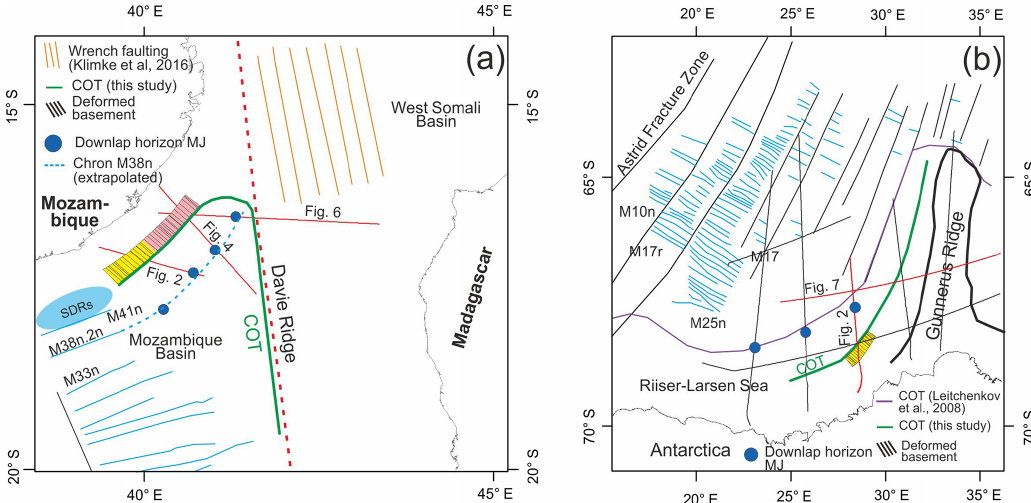
Figure 9. Sketch map illustrating the location of the deformed basement observed at the foot of the continental slope in the Mozambique Basin (a) and the Riiser-Larsen Sea (b) . Solid lines indicate the location of Profiles A to E (Figs. 2, 4, 6 and 7). Blue and black lines highlight magnetic anomalies and fracture zones in the Mozambique Basin and Riiser-Larsen Sea according to Leinweber and Jokat (2012), Leitchenkov et al. (2008) and Müller and Jokat (2017). The continent–ocean transition (COT) as proposed in this study is shown in green. The continent–ocean transition according to Leitchenkov et al. (2008) in the Riiser-Larsen Sea is shown in purple. Orange lines indicate wrench faulting in the West Somali Basin (Klimke et al., 2016). Blue dots mark onlap locations of horizon MJ against oceanic basement. The dashed blue line marks the extrapolation of magnetic chron M38n (Müller and Jokat, 2017) to the study area in the Mozambique Basin. The extrapolation was done by noting the distance of magnetic chron M38n from the continent–ocean transition. Yellow and rose hatched areas mark the location of transpressional (yellow) and transtensional (rose) deformation. The location of Davie Ridge is marked with a thick dashed red line. The location of SDRs in the Mozambique Basin is compiled from Leinweber et al. (2013) and Müller and Jokat (2017).